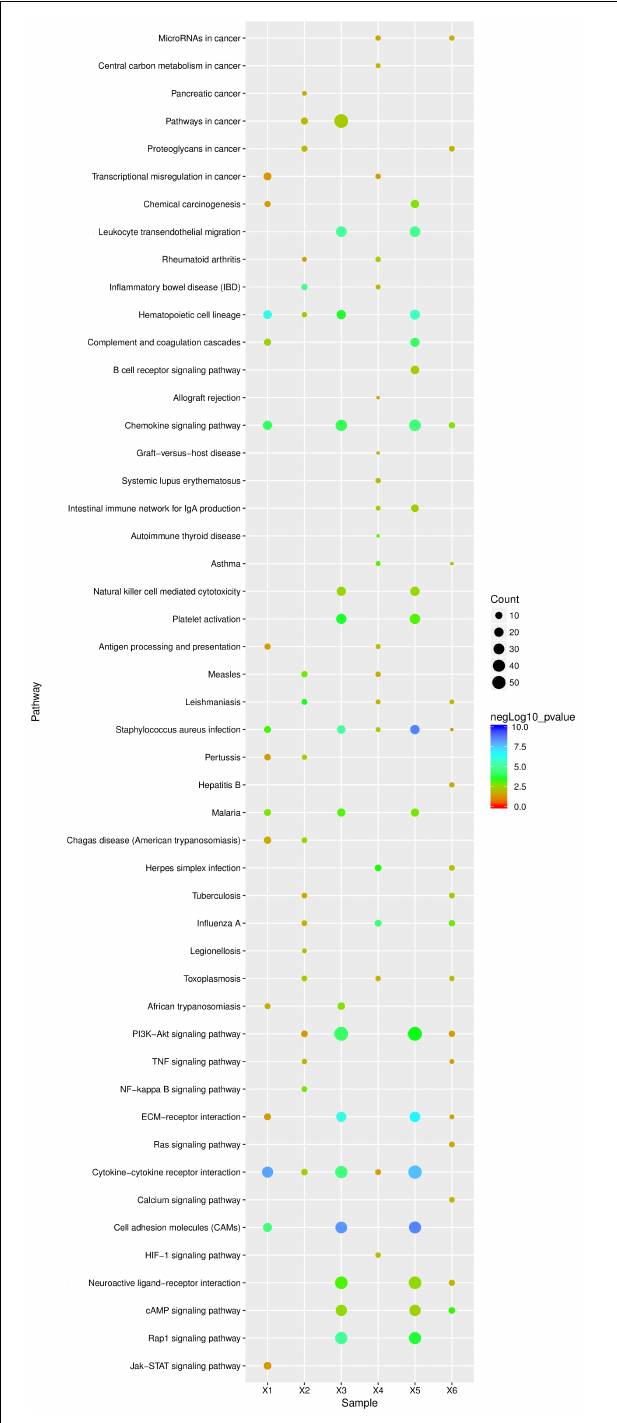
FIGURE 6 | KEGG pathway enrichment analysis of DE unigenes of negative miRNA–mRNA and DE unigenes of RNA-seq. X1, 138 negative miRNA–mRNA interactions with 24 mature miRNAs and 201 validated mRNAs DE in the lung (15 pathways); X2, 916 DE unigenes of RNA-seq in lung tissue (18 pathways); X3, 134 negative miRNA–mRNA interactions with 97 mature miRNAs and 135 mRNAs were found in the trachea (16